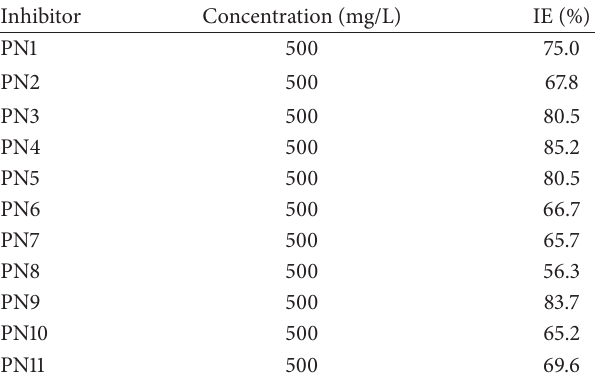
Table 2: Inhibition efficiency of phenyl nitrone for Q235A steel in 3% HCl